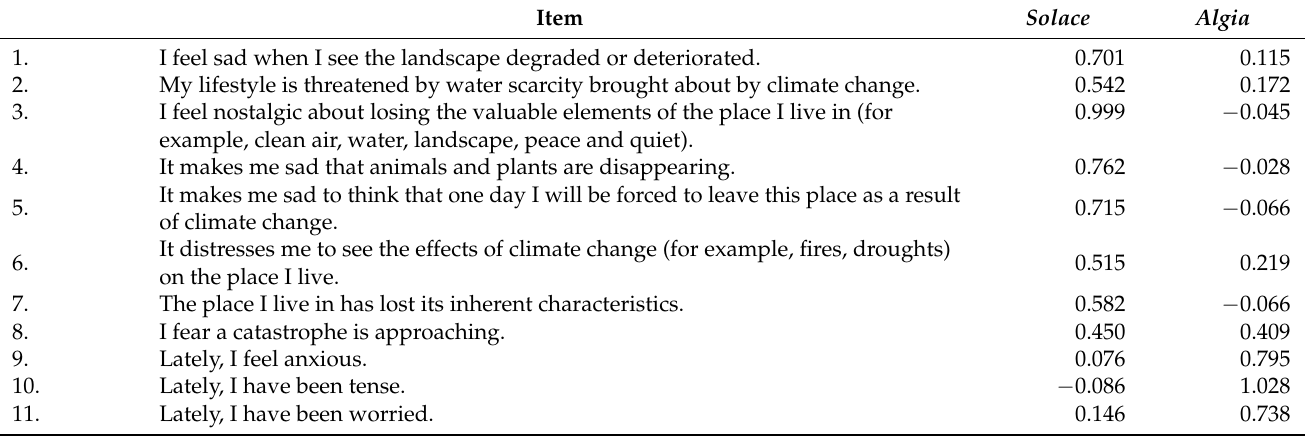
The analysis of the rotated factors matrix (Table 2) indicates that all items have loads greater than 0.3 in their respective factor. However, item 8 “ I fear a catastrophe is ap- proaching ” has a difference of less than 0.2 between factors, so it was eliminated from the SOS. In this way, the SOS was composed of 10 items and two dimensions. Excellent relia- bility indicators were obtained for both the total SOS ( α = 0 .901; ω = 0 .903) and the dimen- sions solace ( α = 0 .87; ω = 0 .88) and algia ( α = 0 .908; ω = 0 .908). Table 2. Rotated factor matrix. Item